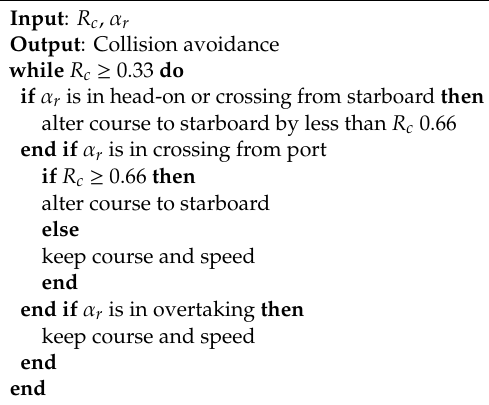
Algorithm 2 Collision avoidance